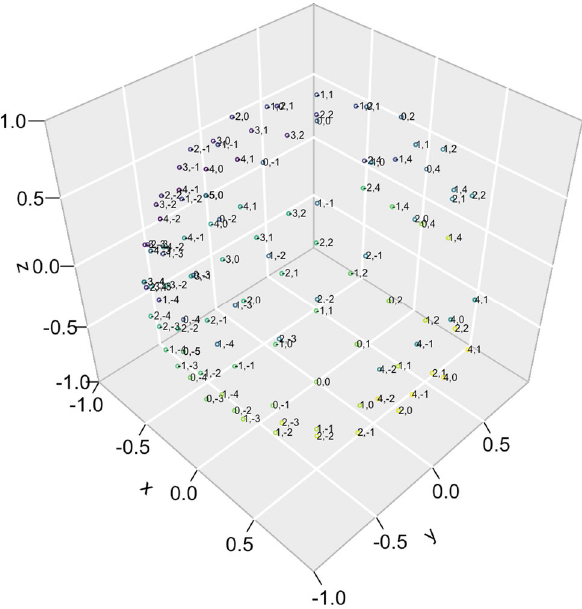
Fig. 1 Two-sphere of radius one formed from the set of the discrete points